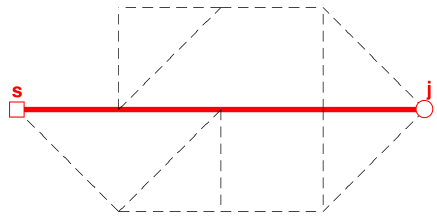
Figure 5. First shortest path from s to j (solid line shows links in path, while dashed lines are not in path).